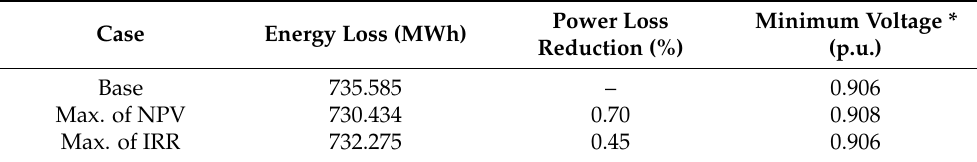
Table 3. Annual energy losses and minimum